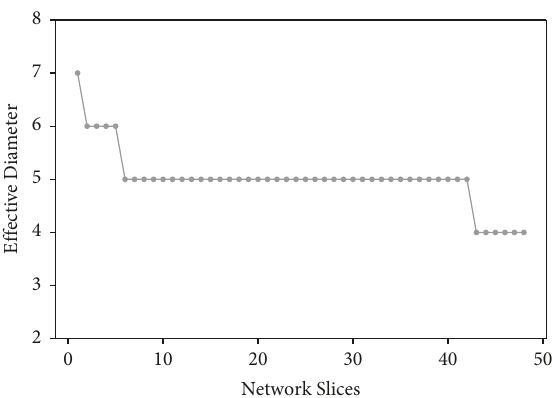
Figure 4: The effective diameters of network slices. Figure 5: Number of edges versus number of nodes in log-log